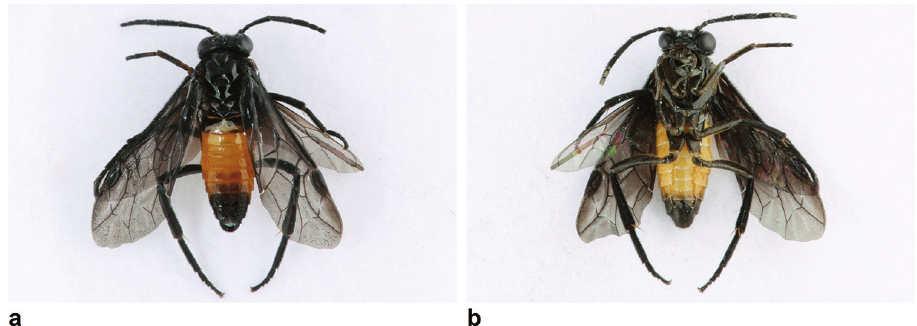
Figure 13. Waldheimia pellucida , male (P4218), body length 6.5 mm. a Dorsal view b ventral view.